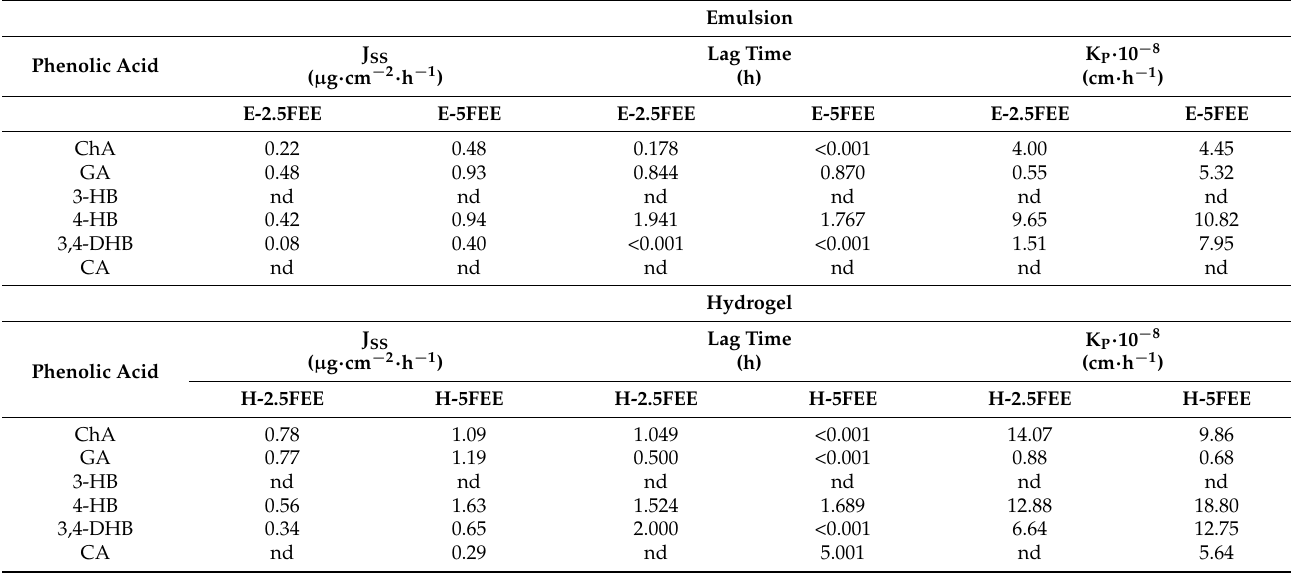
Figure 8. The cumulative mass of phenolic acids in the acceptor fluid during the 24-h penetration after the application of dry ethanolic extracts from E. angustifolium (FEE) in two vehicles. Vertical lines represent the standard deviation, n = 3. Table 4. The parameters characterizing phenolic acid transport through the human skin after the application of ethanolic extracts from E. angustifolium (FEE) in two vehicles.